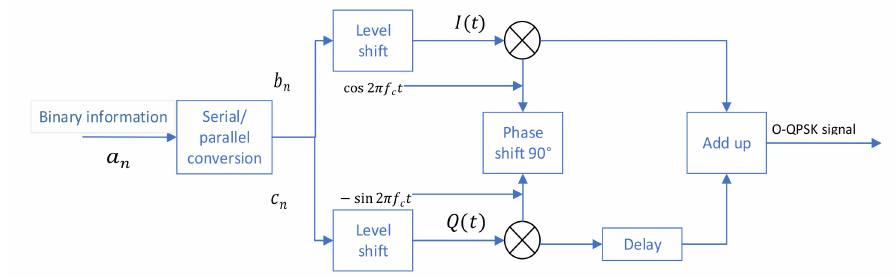
Figure 2. O-QPSK modulation diagram.